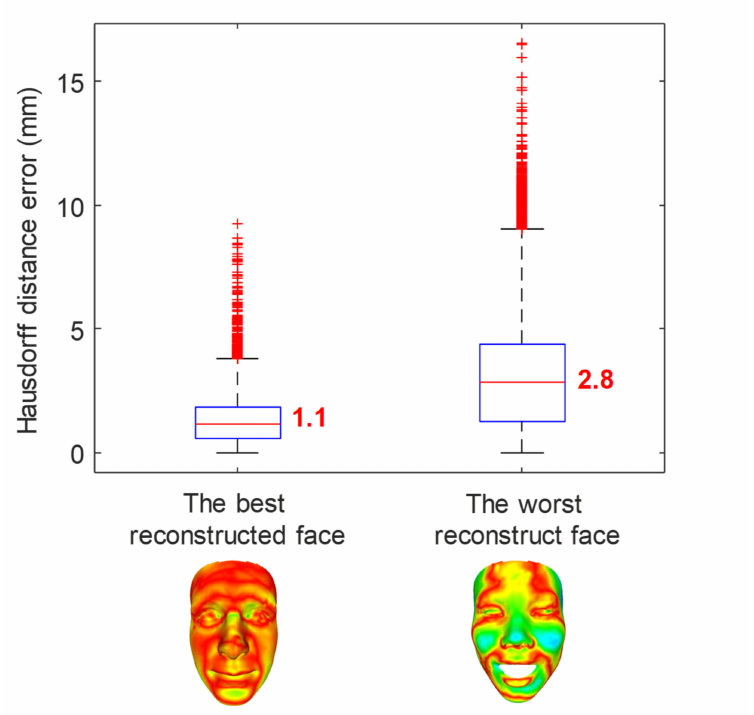
Figure 10. The error of the best and the worst prediction cases of the third method compared with MRI ground truth